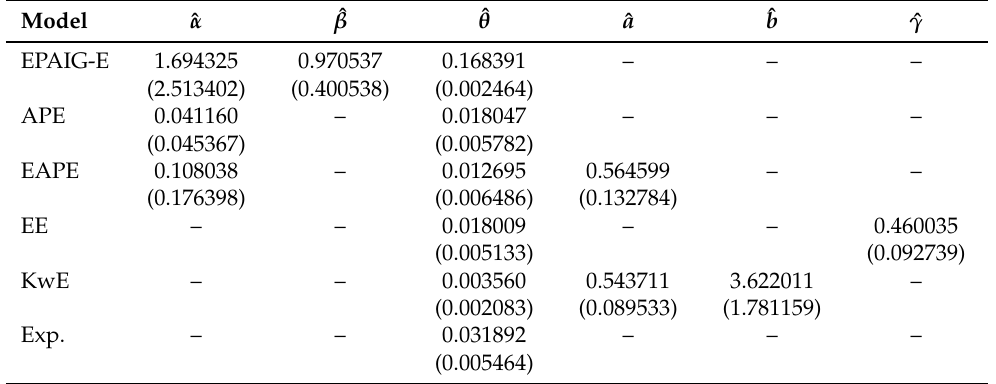
Figure 6. Histogram and estimated pdfs ( left ); empirical and estimated cdfs ( right ) of the EPAIG-E, APE, EAPE, EE, KwE, and Exp. models for the runoff data. Table 2. Estimates and standard errors of parameters of the EPAIG-E model for runoff data.